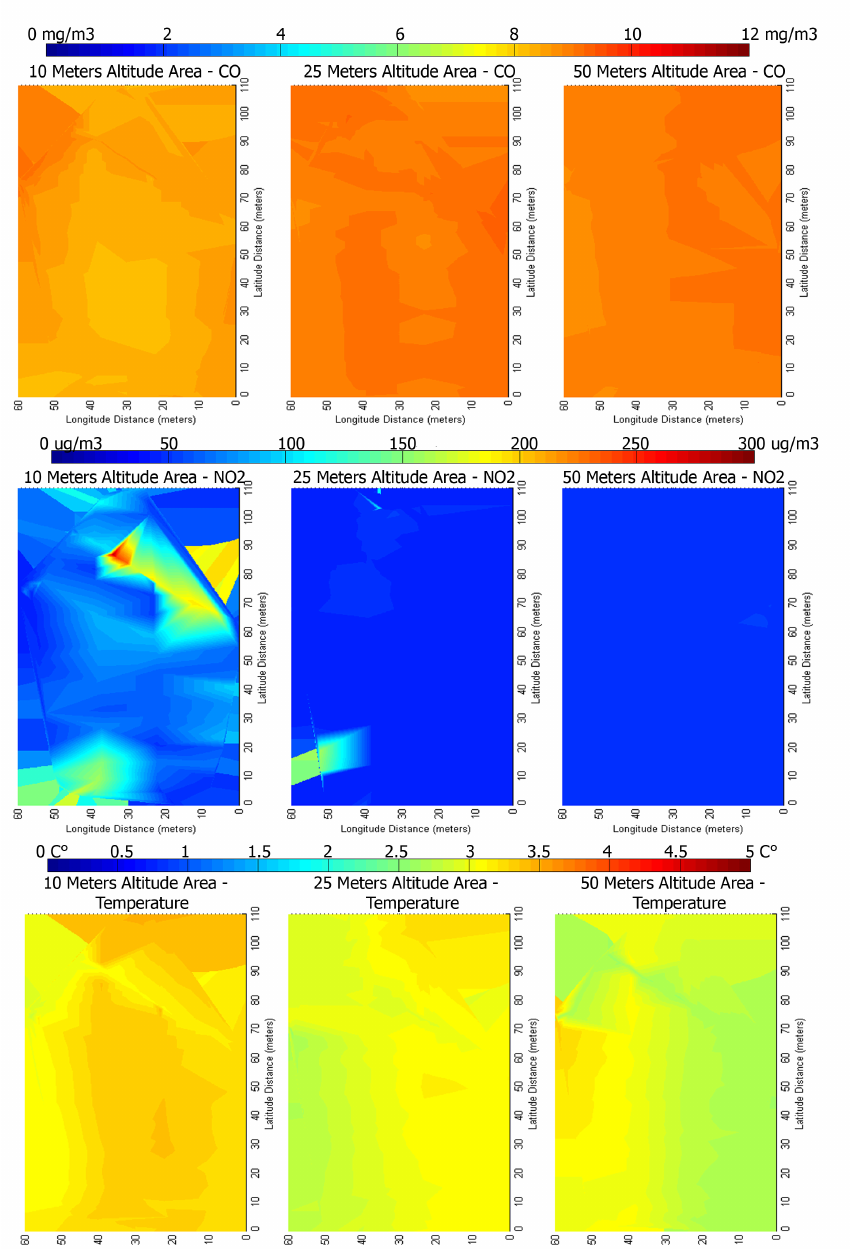
Figure 14. Heat-maps representing changes in concentration for the mission conducted on the outskirts of the city of